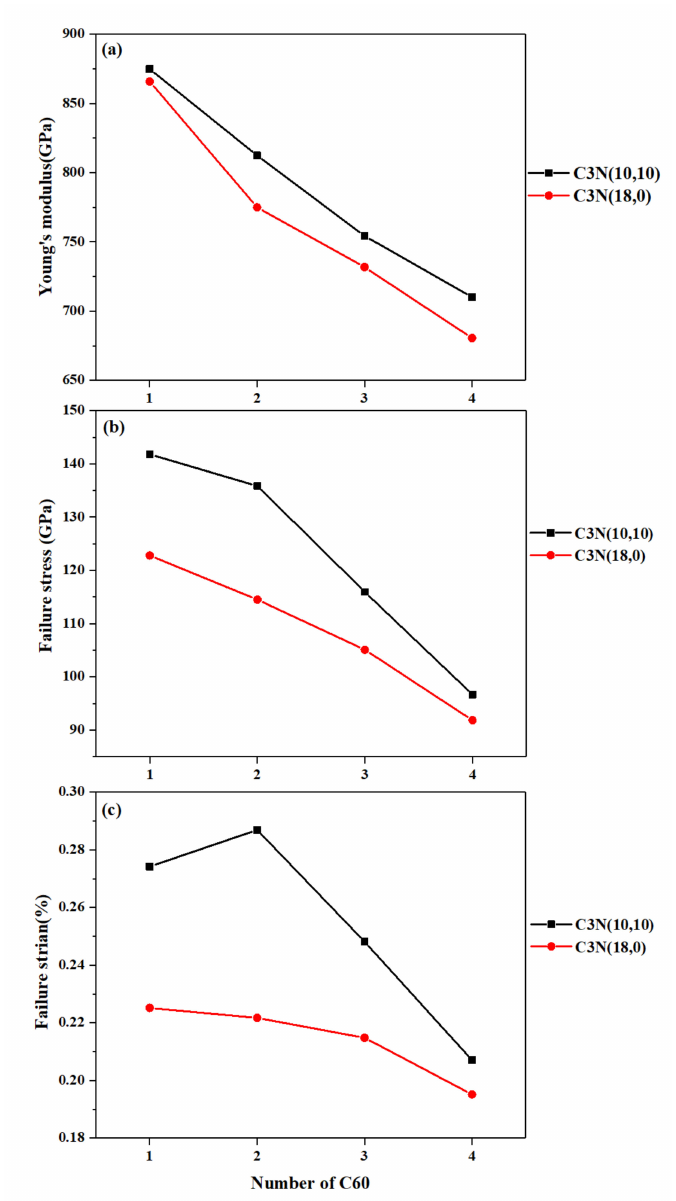
Figure 10. ( a ) Young’s modulus, ( b ) failure stress, and ( c ) failure strain of C 3 N nanobuds under uniaxial tensile tests at 300